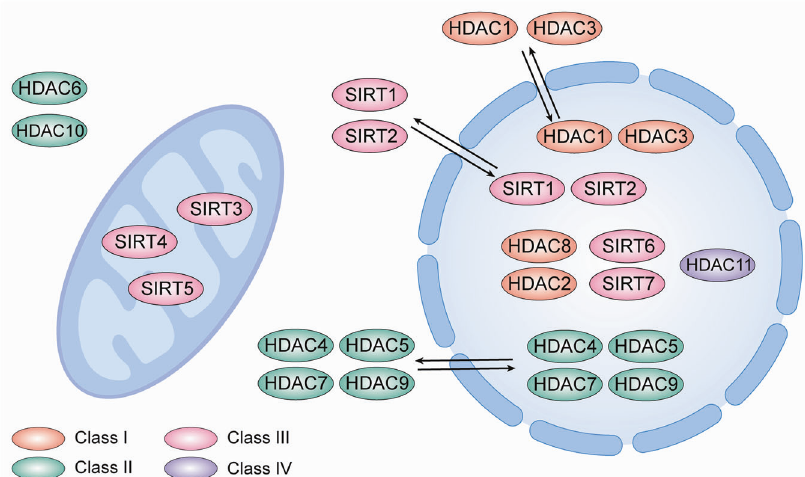
Fig. 1 Cellular sub-localization of HDAC family proteins. Localization of Class I-IV HDAC proteins in cytoplasm, nucleus, and